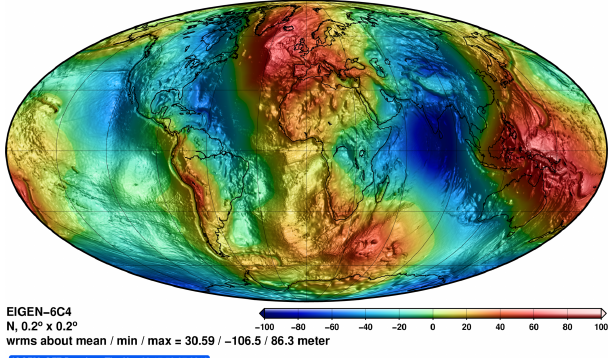
Figure 6. Geoid undulation computed from the EIGEN-6C4 com- bined gravity field model expanded up to a degree and order of 2190.